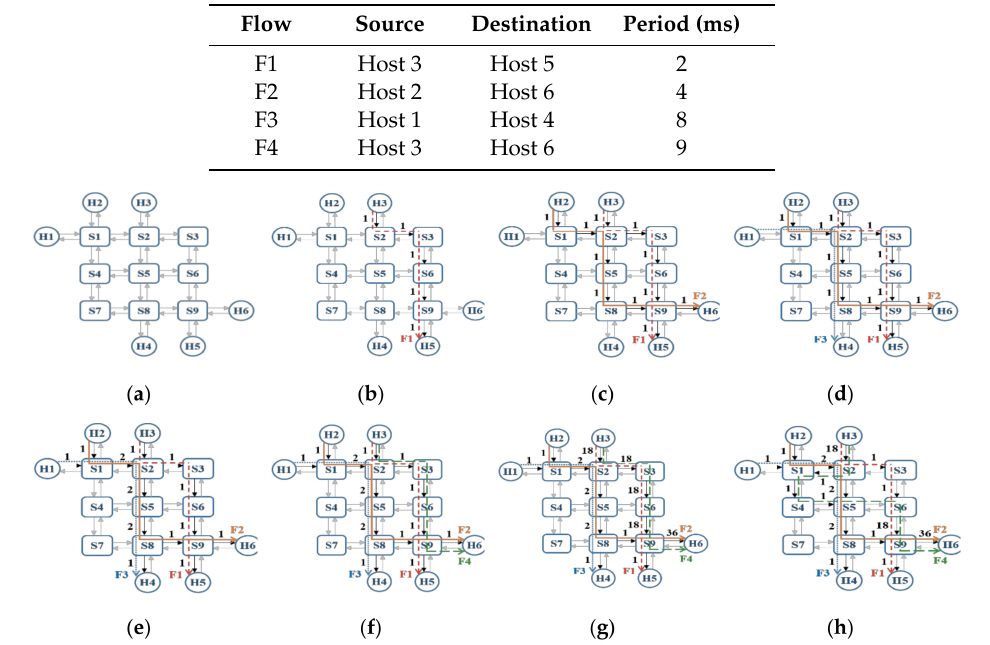
Table 2. The information of each flow in the example of Section 4.3.